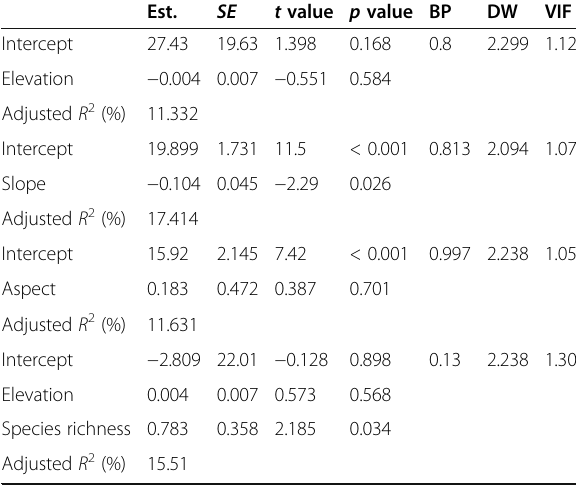
Table 2 The effect of elevation, slope, aspect, and species richness on AGC stock